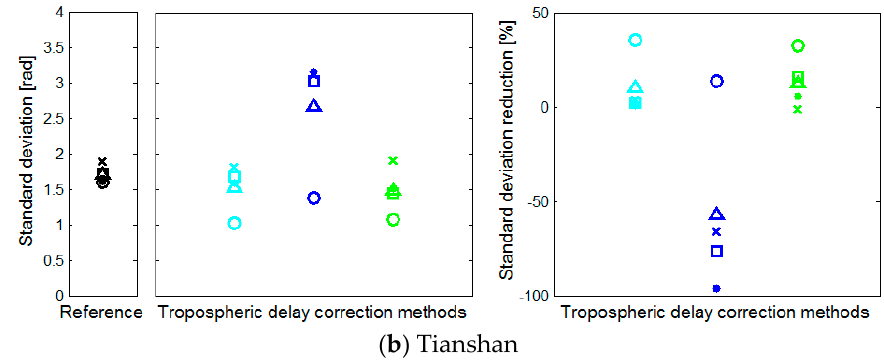
Figure 13. Comparisons between different tropospheric correction methods in: ( a ) California; and ( b ) Tianshan. Left panel: STD of the unwrapped interferograms. Right panel: STD after correction of the tropospheric delay with different methods (colored symbols). Other illustrations show the STD reduction. Point, circle, cross, and square symbols correspond to different interferograms, and triangular symbols represent the average value. Wet delay components are indicated by (w) and hydrostatic delay components by (h).